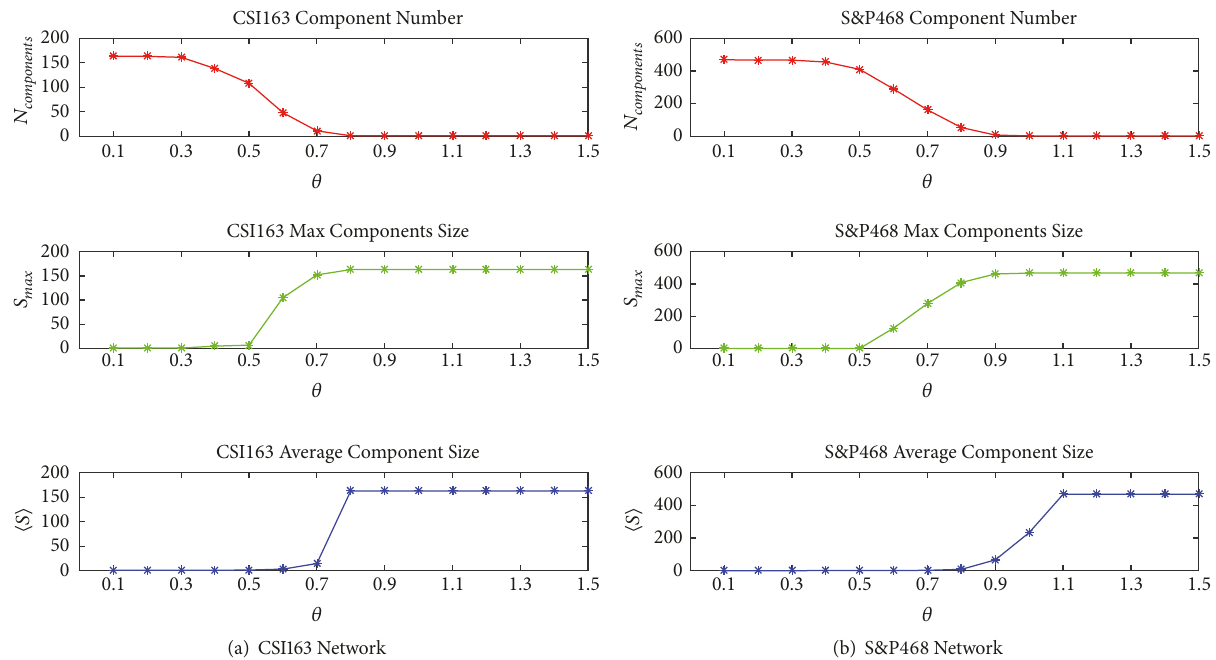
Figure 9: The component properties of the components number 𝑁 𝑐𝑜𝑚𝑝𝑜𝑛𝑒𝑛𝑡𝑠 (red), the max component size 𝑆 𝑚𝑎𝑥 (green), and the average component size ⟨𝑆⟩ (blue) are plotted for CSI163 and S&P468 with different thresholds 𝜃 in (a) and (b), respectively. Both networks show similar transitions when the networks transform from a large number of small isolated components into a connected giant network. Before the transition interval, edges are filtered leaving isolated vertices are not correlated. After the transition interval, edges are preserved making most vertices connected to form a single giant network in which all vertices are correlated.